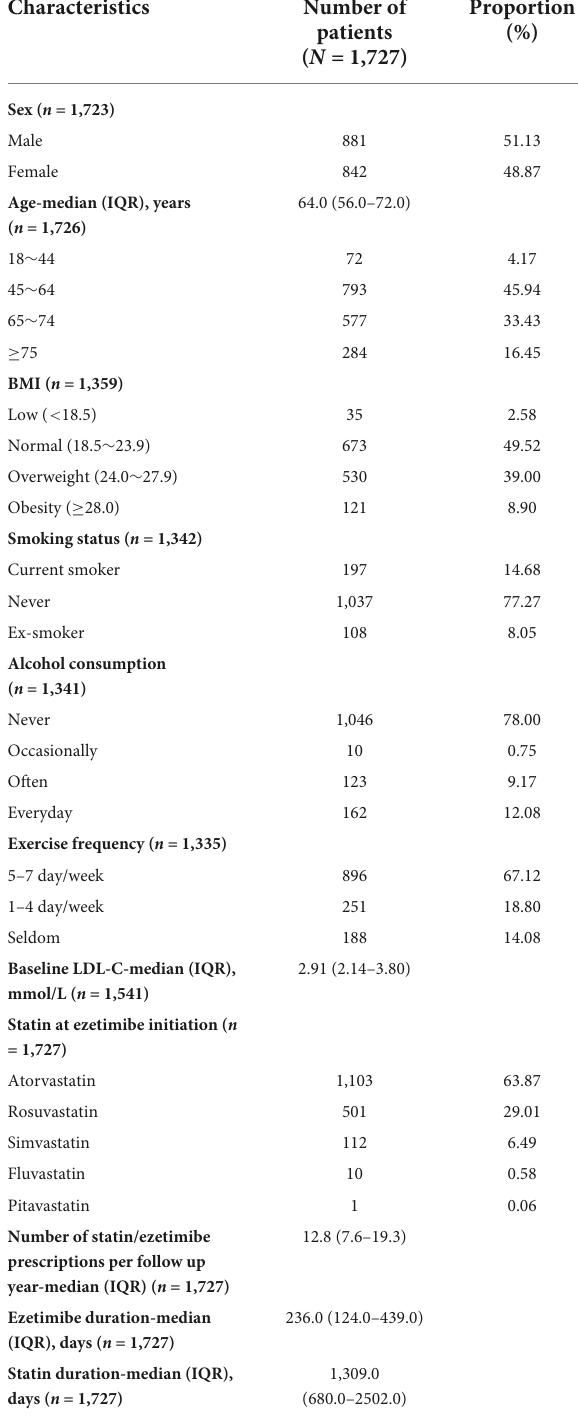
TABLE 1 Baseline characteristics and lipid-lowering treatment of included